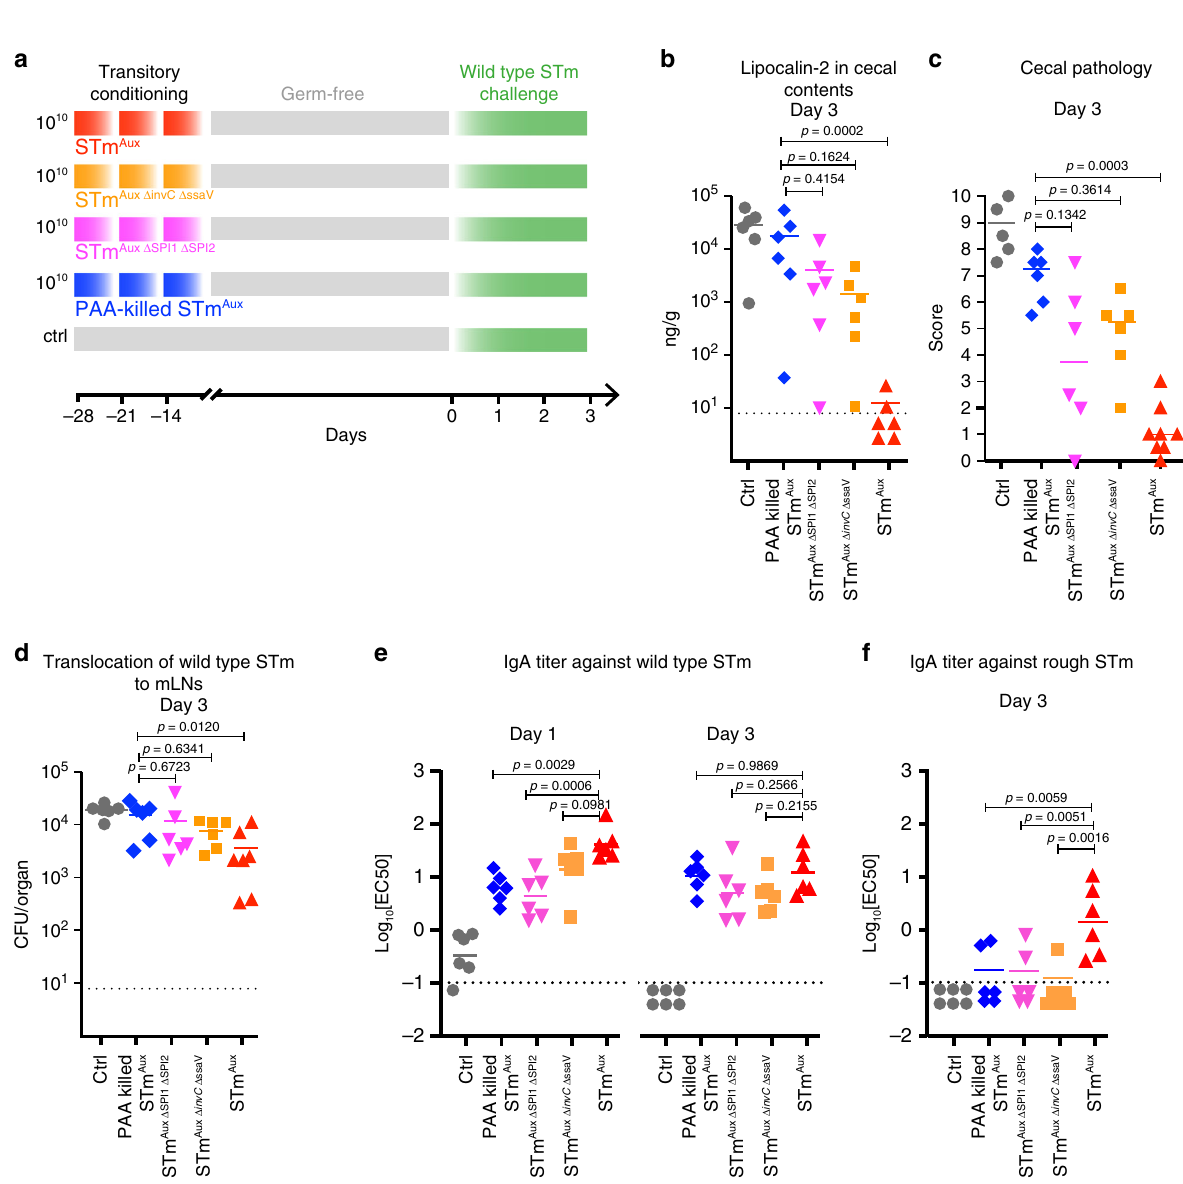
to lose its auxotrophic phenotype during these experiments (no recovery of STm growth from ex vivo intestinal samples in non-supplemented control medium). Even STm Aux re-isolated from an sDMDMm mouse after 8 months colonized germ-free mice fully reversibly. Following gavage of 10 10 CFU of either the 8-month re-isolate or the original lab strain, all mice ( n = 5